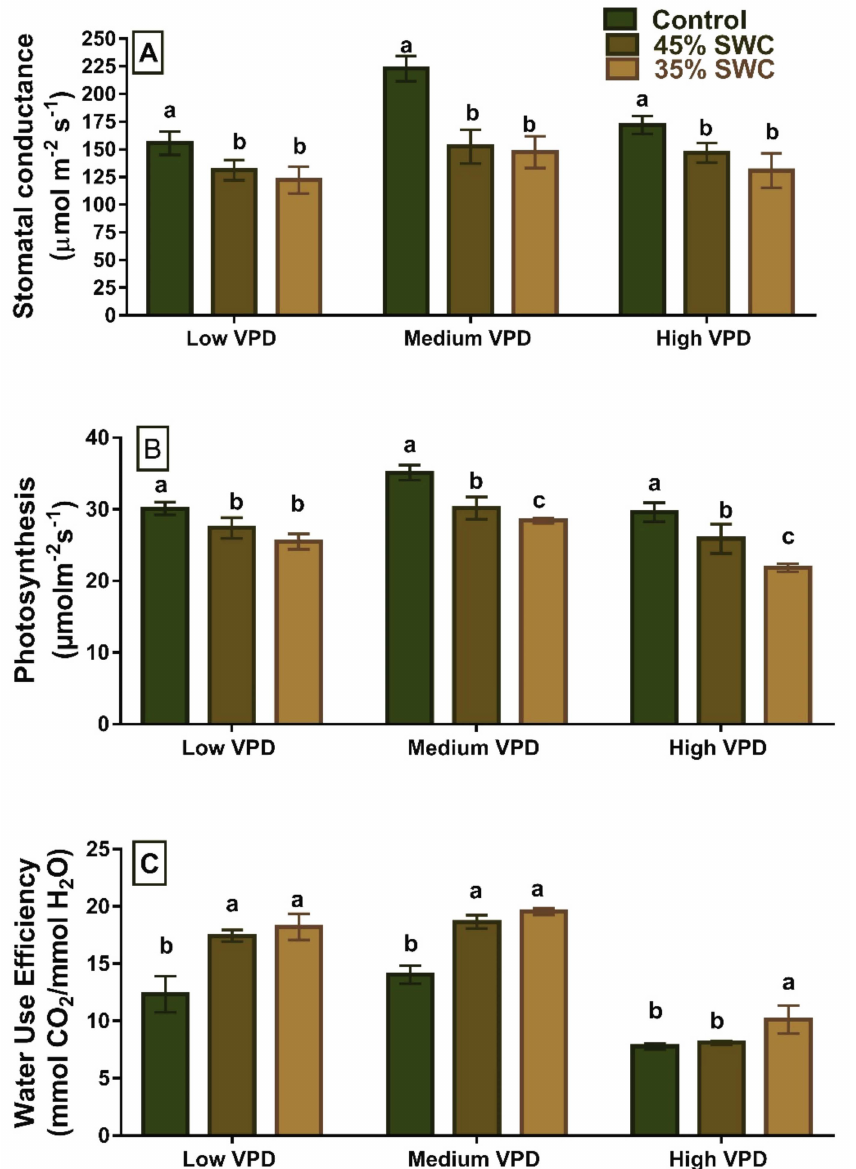
Figure 2. Gas exchange parameters ( A ) stomatal conductance ( µ mol m − 2 s − 1 ), ( B ) photosynthesis ( µ mol m − 2 s − 1 ), and ( C ) water use efficiency (mmol CO 2 /mmol H 2 O) of maize to different soil water content (SWC) well-watered, 45% SWC, and 35% SWC under low, medium and high vapor pressure deficit (VPD) conditions. The bars (Average ± S.E.) at each VPD represented with the same alphabet were not significantly different from each other at p <